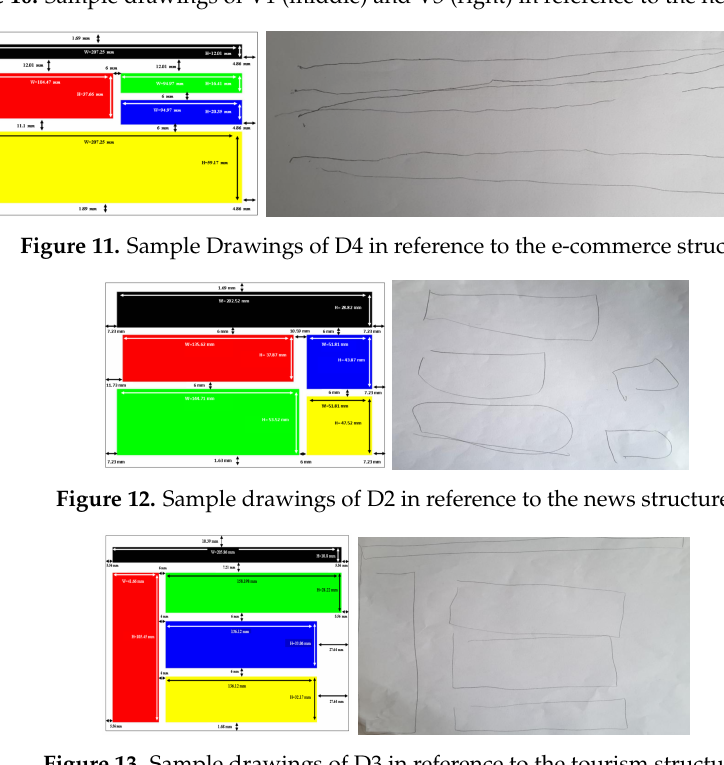
Figure 13. Sample drawings of D3 in reference to the tourism structure.